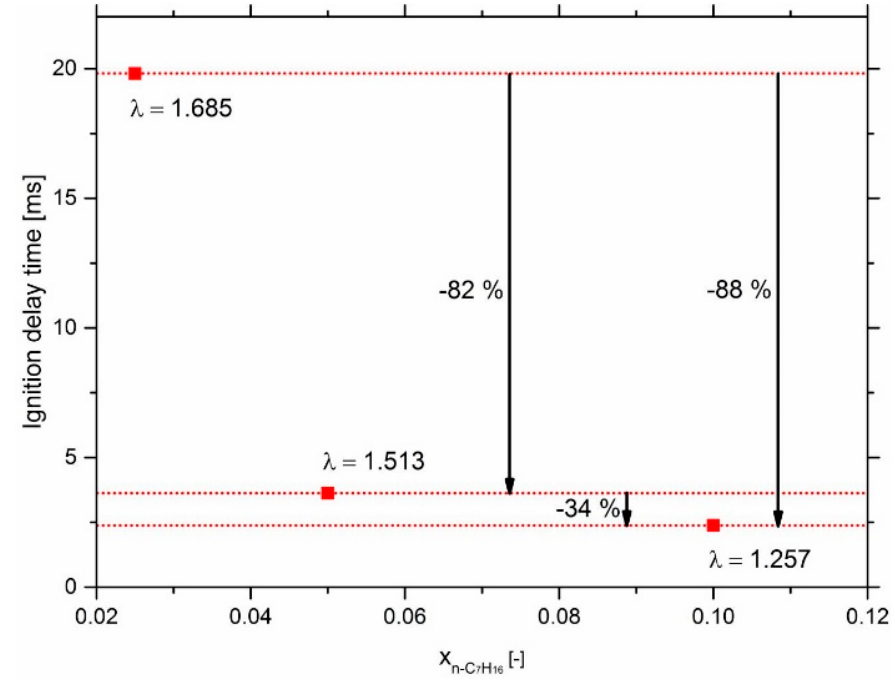
Figure 14. Interpolated IDT of a gas mixture consisting of 95 mol % CH 4 , 5 mol % C 3 H 8 , and various amounts of n-C 7 H 16 (variation of x n-C 7 H 16 ) at an end of compression temperature of 770 K and pressure of 60 bar.